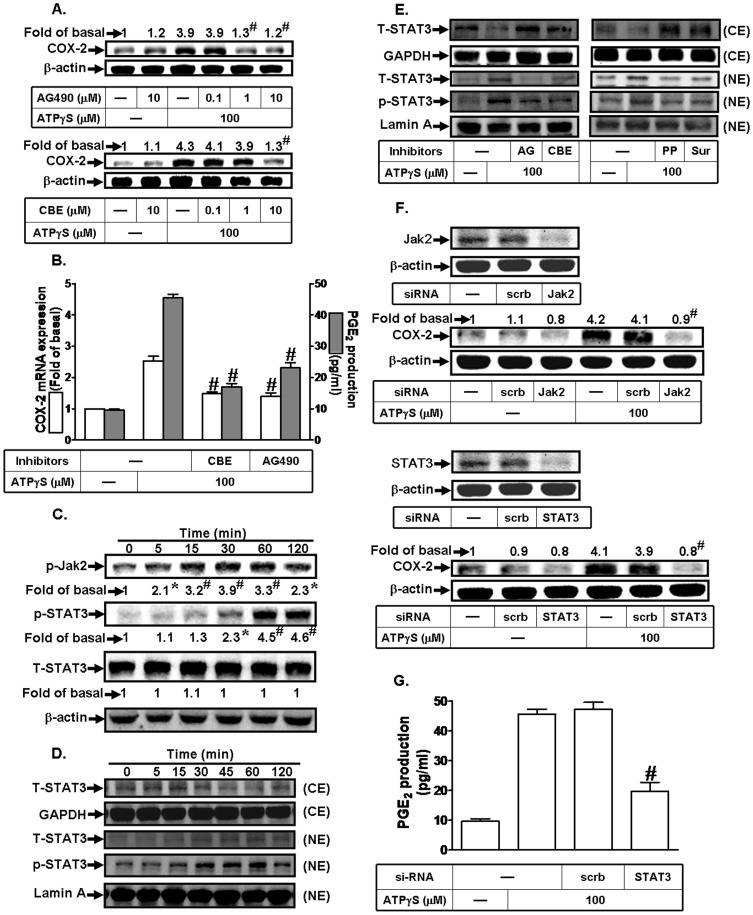
ATPγS induces COX-2 expression via Jak2/STAT3 in A549 cells.Cells were pretreated with AG490 or CBE for 1 h, and then incubated with ATPγS for (A) 6 h or (B) 2 h. The levels of COX-2 (A) protein and (B) mRNA were analyzed by western blot and real-time PCR, respectively. (A) The media were collected and analyzed for PGE2 release. (C) Cells were treated with ATPγS (100 µM) for the indicated time intervals. The cell lysates were analyzed by western blot using an anti-phospho-Jak2, anti-phospho-STAT3, anti-STAT3, or anti-β-actin antibody. Cells were pretreated (D) without or (E) with AG490 (10 µM), CBE (10 µM), PPADS (10 µM), or suramin (10 µM) for 1 h, and then incubated with ATPγS (100 µM) for (D) the indicated time intervals or (E) 60 min. The cytosolic and nuclear fractions were prepared and analyzed by western blot using an anti-phospho-STAT3 or anti-STAT3 antibody. GAPDH and Lamin A were used as a marker protein for cytosolic and nuclear fractions, respectively. (F) Cells were transfected with siRNA of scrambled, Jak2, or STAT3, and then incubated with ATPγS for 6 h. The levels of Jak2, STAT3, and COX-2 expression were analyzed by western blot. The media were collected and analyzed for PGE2 release. Data are expressed as mean±S.E.M. of three independent experiments. #
p<0.01, as compared with the cells exposed to ATPγS alone (A, B), the cells exposed to vehicle alone (C), or the cells transfected with scrambled siRNA and exposed to ATPγS alone (F, G).